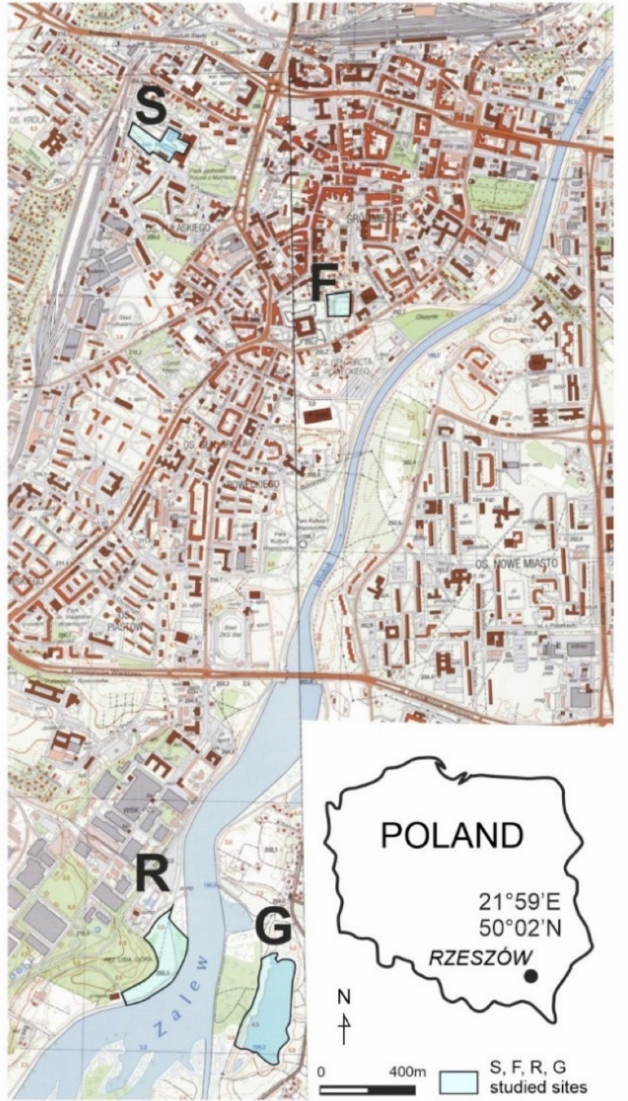
Figure 1. Study area: S—open swimming pools, F—multi-media fountain, R—reservoir, G—gravel pit lake (base map: Topographic map